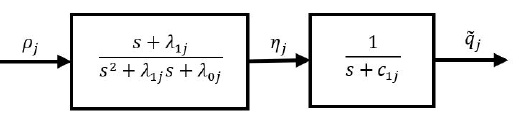
Figure 3. The j th component of the closed-loop system when the sliding surface σ j = 0 is reached, j = 1, · · · , n